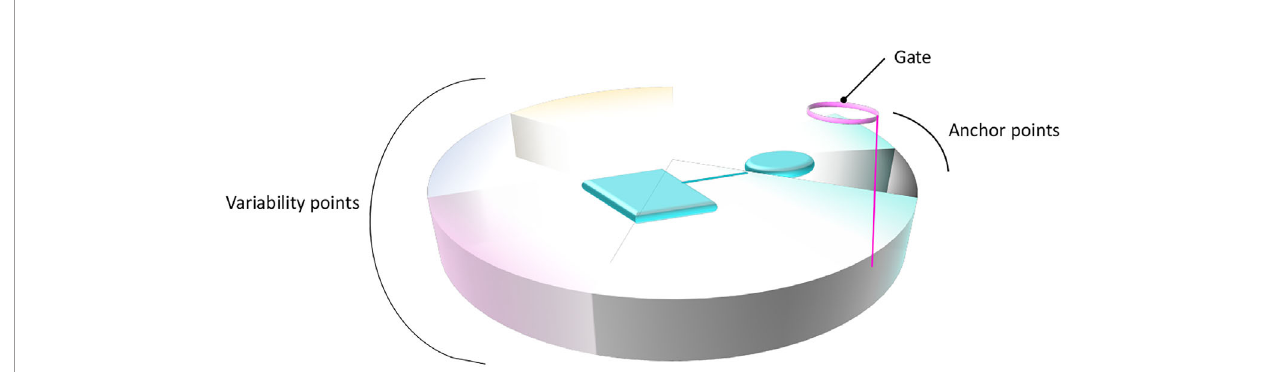
FIGURE 4 | General structural annotation of the primary binding site of LeuT fold transporters. Gathering the information available from the distinct studies on the SLC6 and SLC7 members permits to structurally and functionally map the binding site of LeuT fold transporters. The binding site is symbolized as a disc divided into distinct portions that constitute the binding site, following the same color code as in Figure 1 . The functional annotation of each area is indicated on the side of the disc. A bound ligand is represented in cyan. The anchored part of the ligand, conserved within subgroups is shown as a cylinder. The part of the ligand allowing variability and conferring various transport activities is shown as a